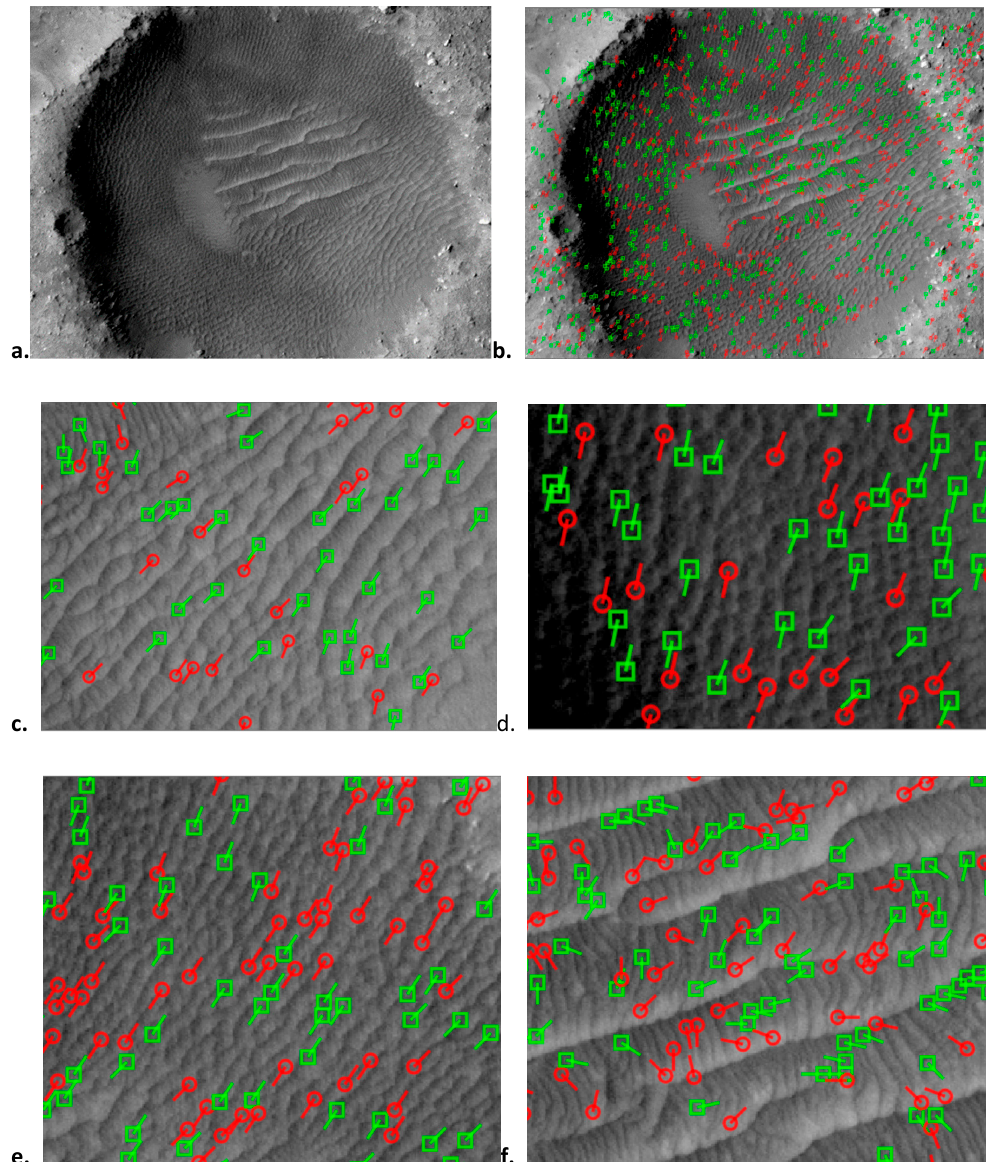
Figure 15. Site L02. (175.561, − 14.53 decimal degrees, − 263,485.6683m, − 860,874.5724m, Projection GCS_Mars). ( a ) Raw image. 25 cm/pixel. ( b ) Defect extraction. ( c ) Zoom of field with a combination of sinuous and crossing ridges. ( d ) Zoom of field with primarily crossing pattern. ( e ) Zoom of field with primarily linear ridges. ( f ) Zoom of central region with widely spaced ridges and crossing structure. Color key same as Figure 10.